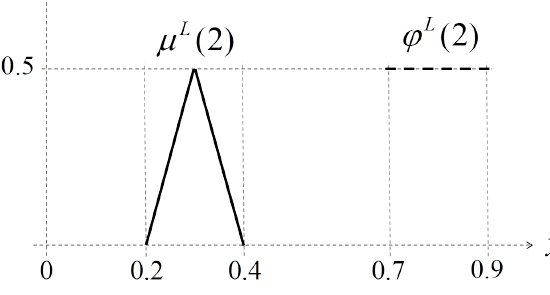
Figure 11. µ L ( 2 ) and ϕ L ( 2 ) according to Example